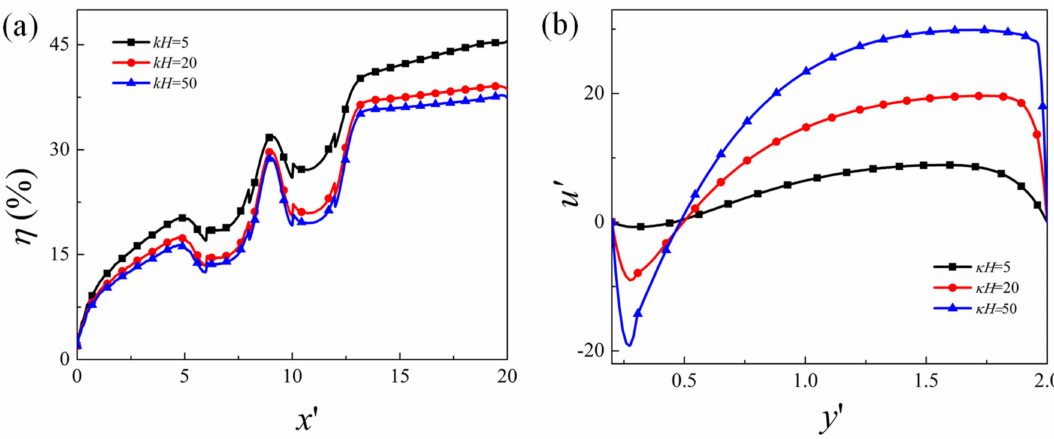
Figure 8. ( a ) Evolution of the mixing efficiency along the channel length direction, ( b ) mainstream velocity component u (cid:48) along the cross-section located at the center of the first obstacle x (cid:48) = 7 for EDL thickness: kH = 5, 20, and